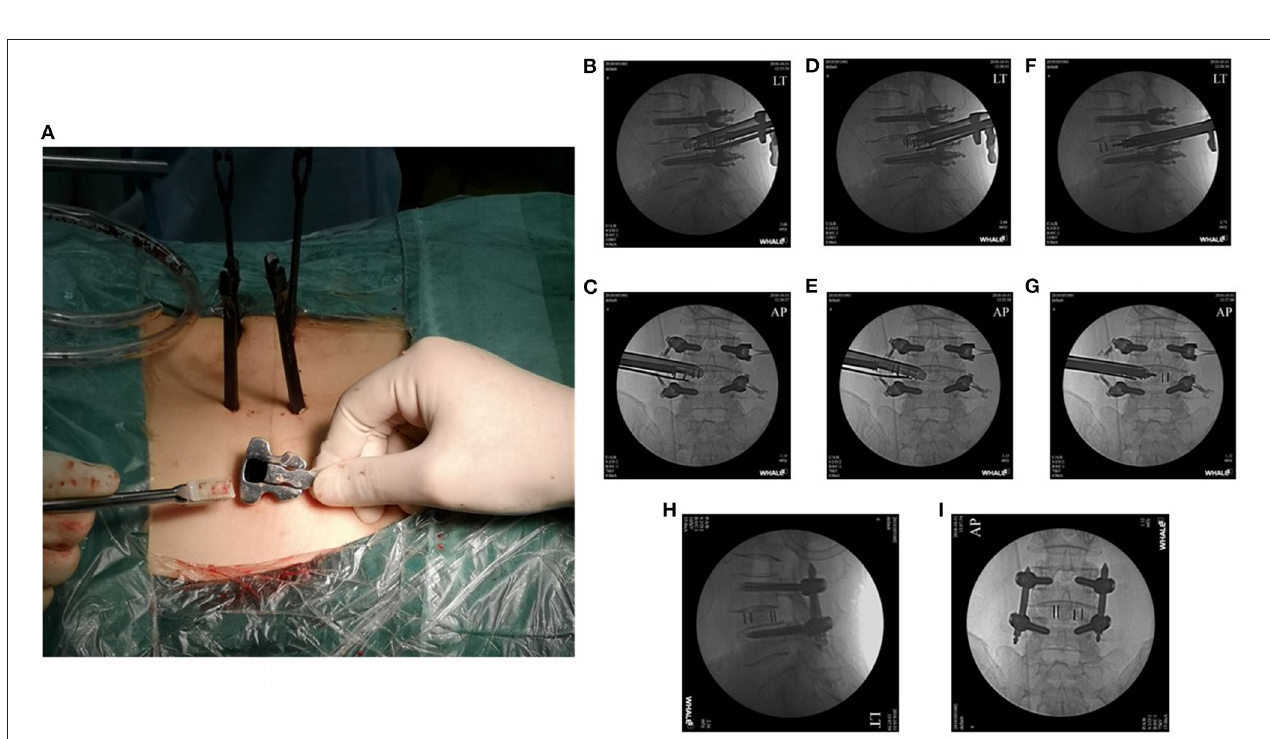
FIGURE 4 | A conventional cage was placed through the working tube under fluoroscopic guidance (A–G) . The final cage position is shown in the anteroposterior and lateral X-rays (H,I) .